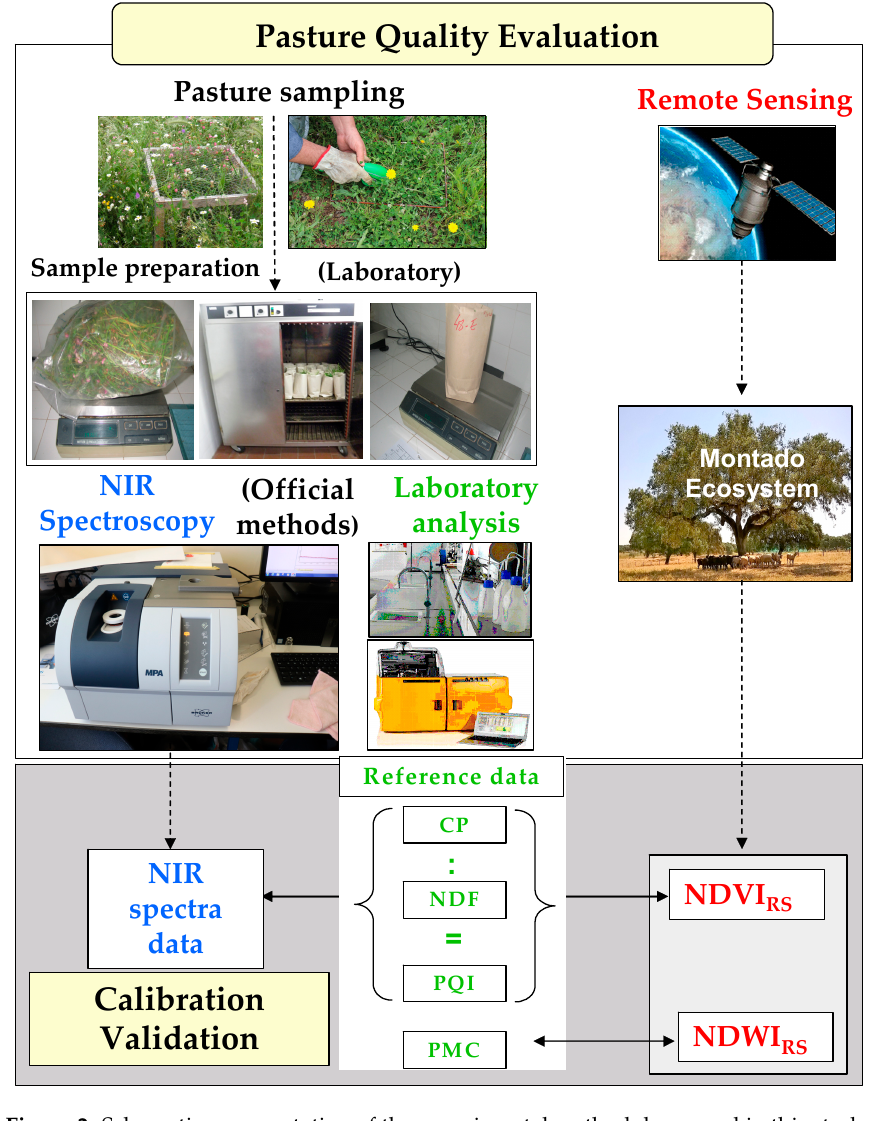
Figure 2. Schematic representation of the experimental methodology used in this study.